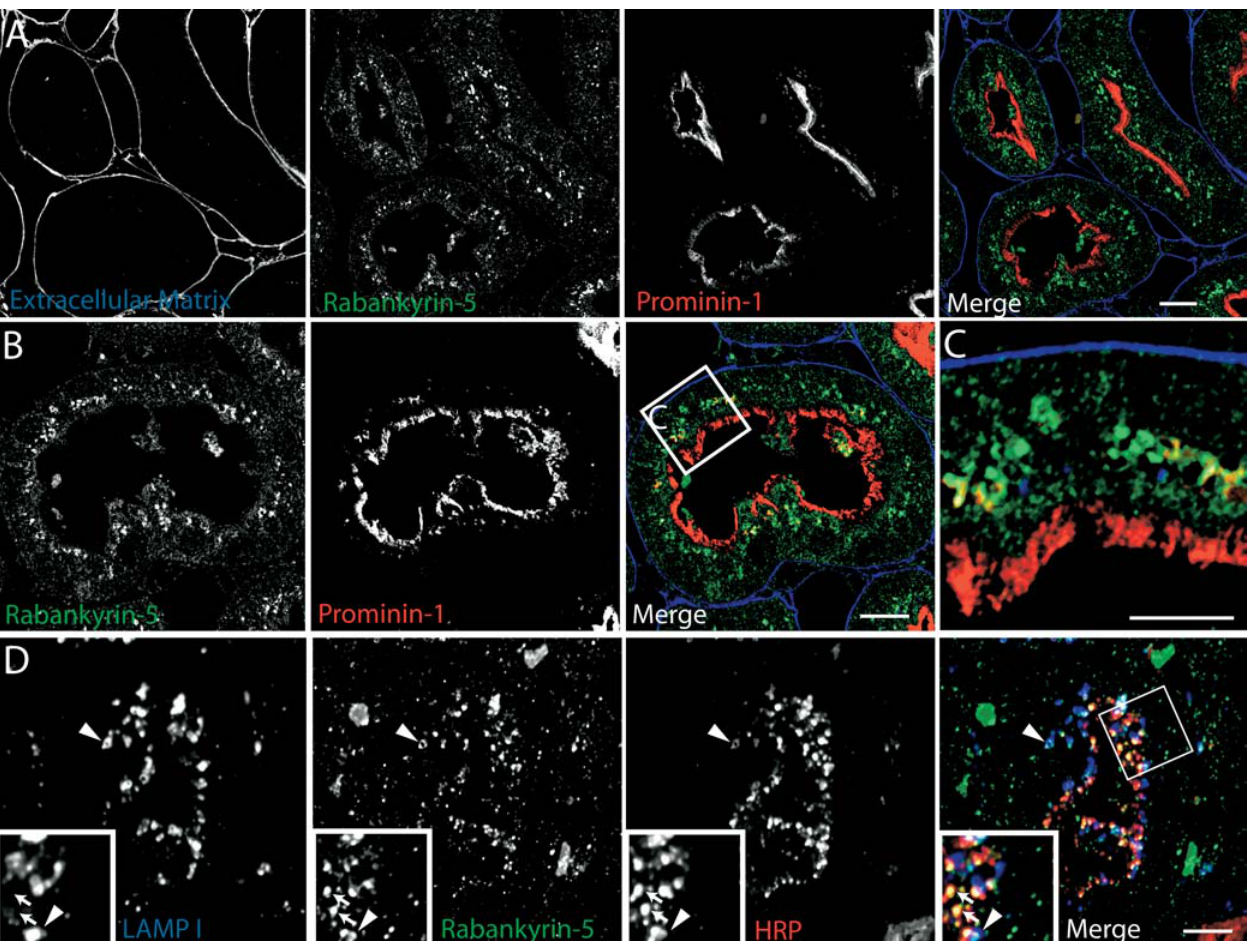
Figure 8. Rabankyrin-5 Localises on Vesicular Structures Underlying the Apical Brush Border in Mouse Kidney Proximal Tubules Mice were perfused either (A–C) directly with 4% PFA or (D) 5 min after injection of HRP into the femoral vein. Immunofluorescence was performed on semi-thin cryosections (500 nm). (C) Higher magnification of the inset in (B). Scale bars represent 10 l m. DOI: 10.1371/journal.pbio.0020261.g008